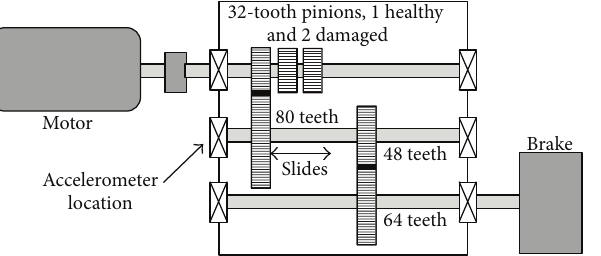
Figure 3: Gearbox test bed